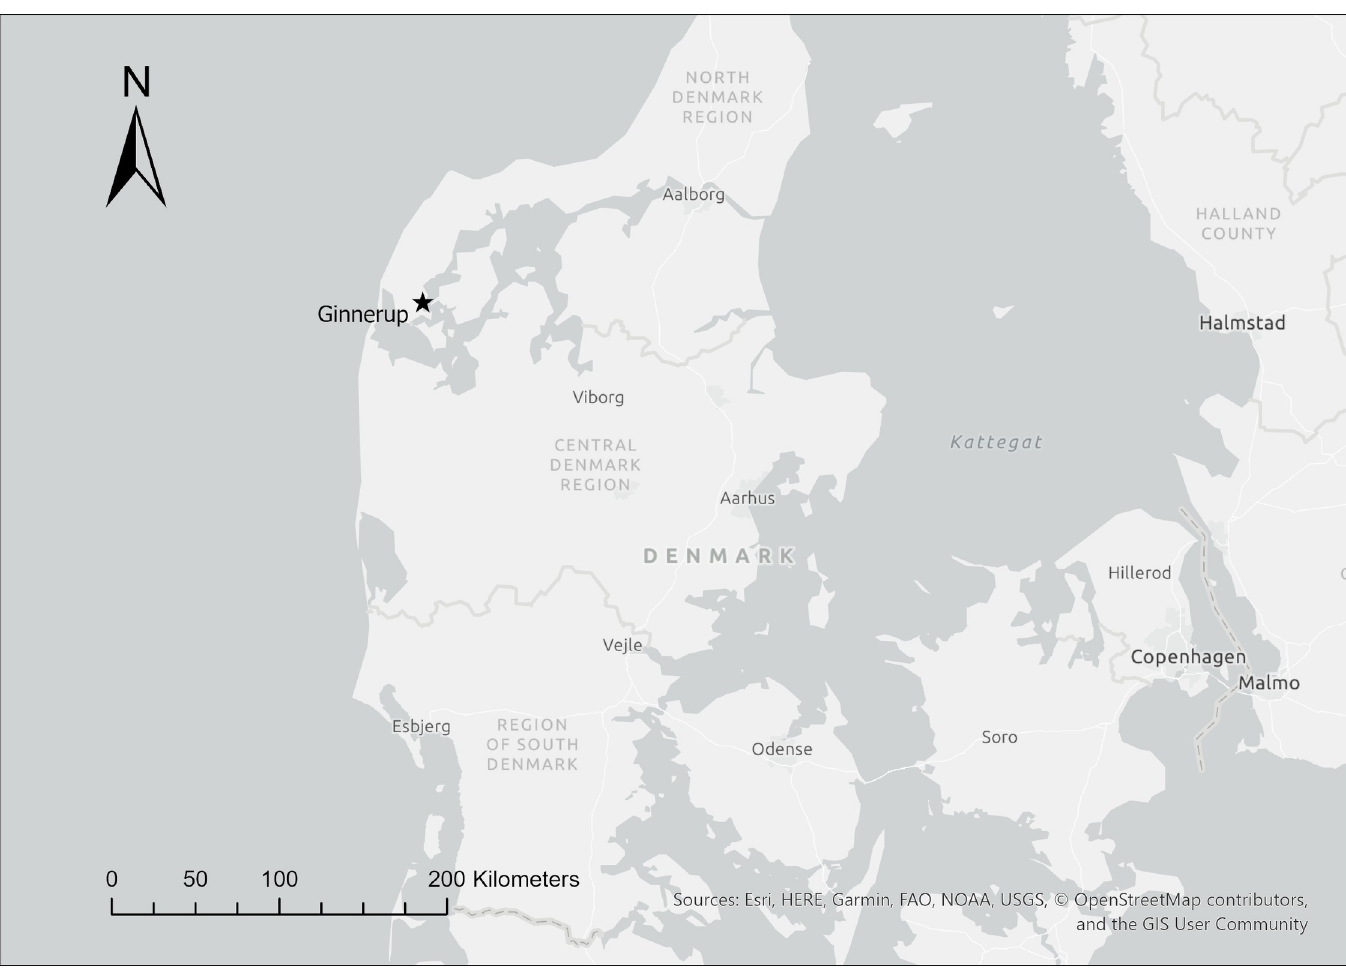
Fig 3. Map showing location of the Late Bronze Age site analyzed within this paper from Thisted County, Denmark. This map was generated using ESRI ArgGIS Pro software and basemaps, licensed to the National Museum of Denmark. The base map and data are from OpenStreetMap and OpenStreetMap Foundation.